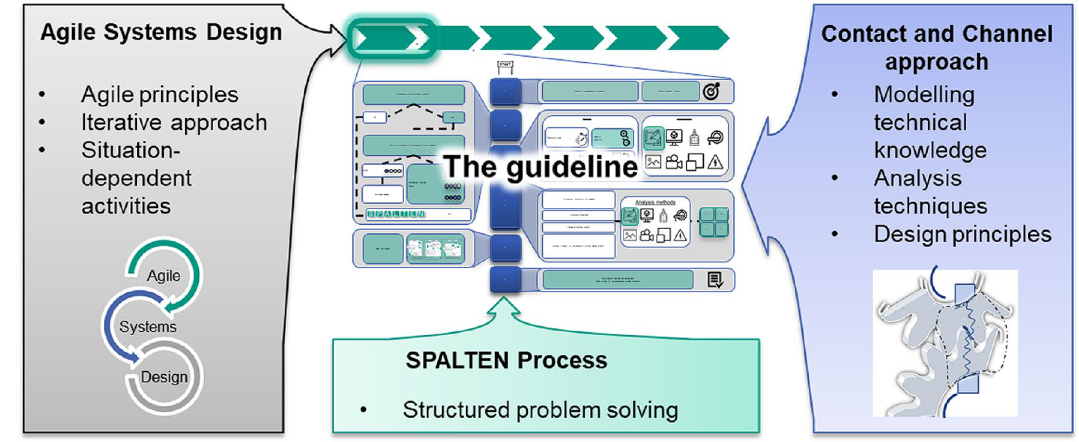
Fig. 5 Development of the guideline through the integration of the ASD-Agile Systems Design, SPALTEN and C&C 2